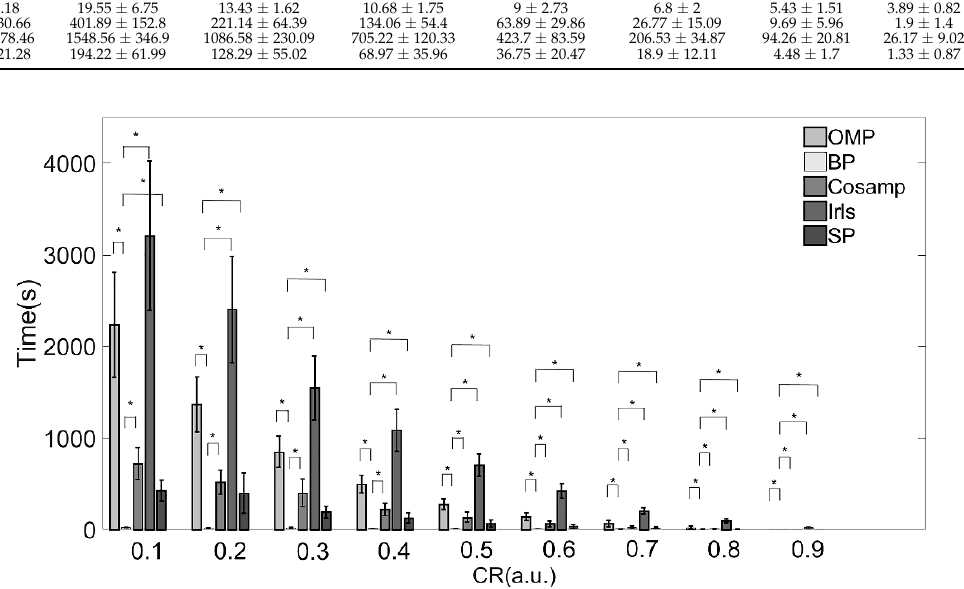
Figure 4. Execution times of various reconstruction algorithms. Note: * Indicates statistical significance via two-sample t -tests. Table 3. Execution times (in seconds) of various reconstruction algorithms. Values are mean ± SD.